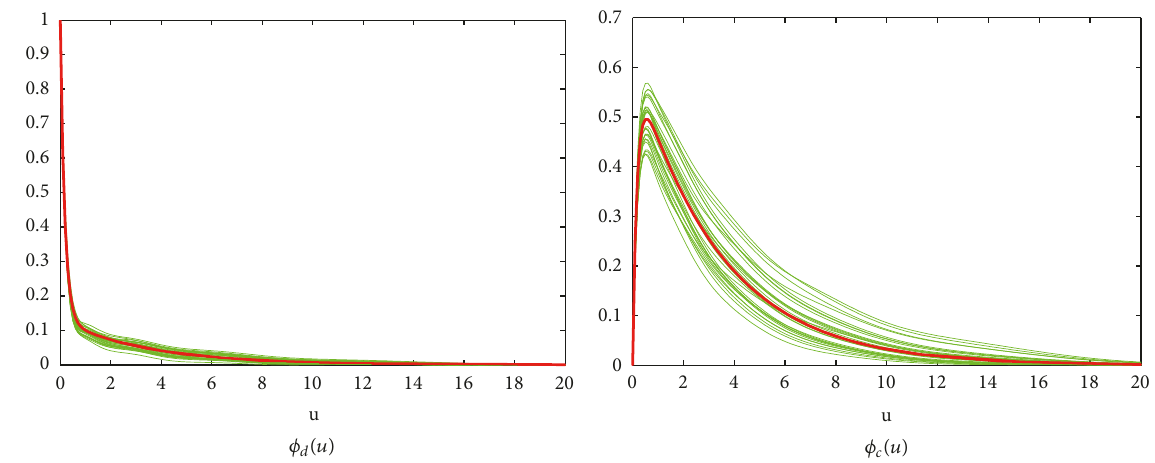
Figure 1: Estimating the ruin probability for exponential claim sizes, true curve (red curve) and 30 estimated curves (green curves).